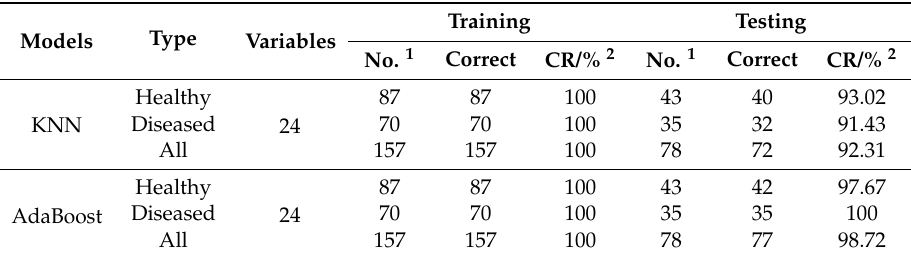
Table 4. Classification results based on RGB